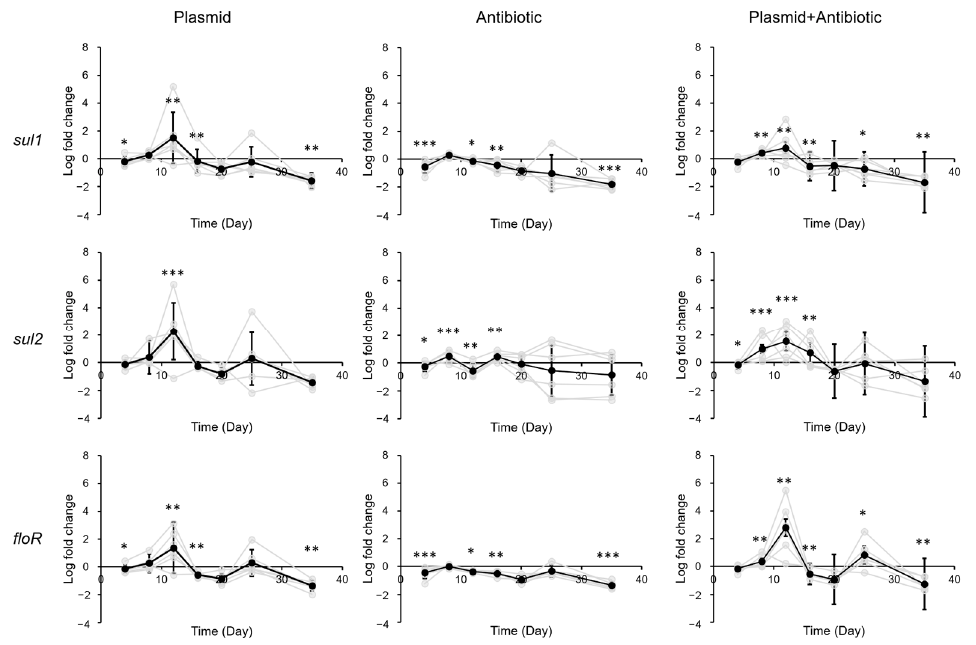
Figure 4. Change in ARG levels in mouse cecum after exposure to pR55 (plasmid), sulfadiazine (antibiotic), or pR55+sulfadiazine (plasmid+antibiotic). Each gray line indicates a mouse group (male groups 1–3, female groups 1–3). Black line indicates average of all six groups. Error bars indicate standard deviation of 6 replicates (3 males and 3 females). *, p < 0.05; **, p < 0.01; ***, p < 0.001.